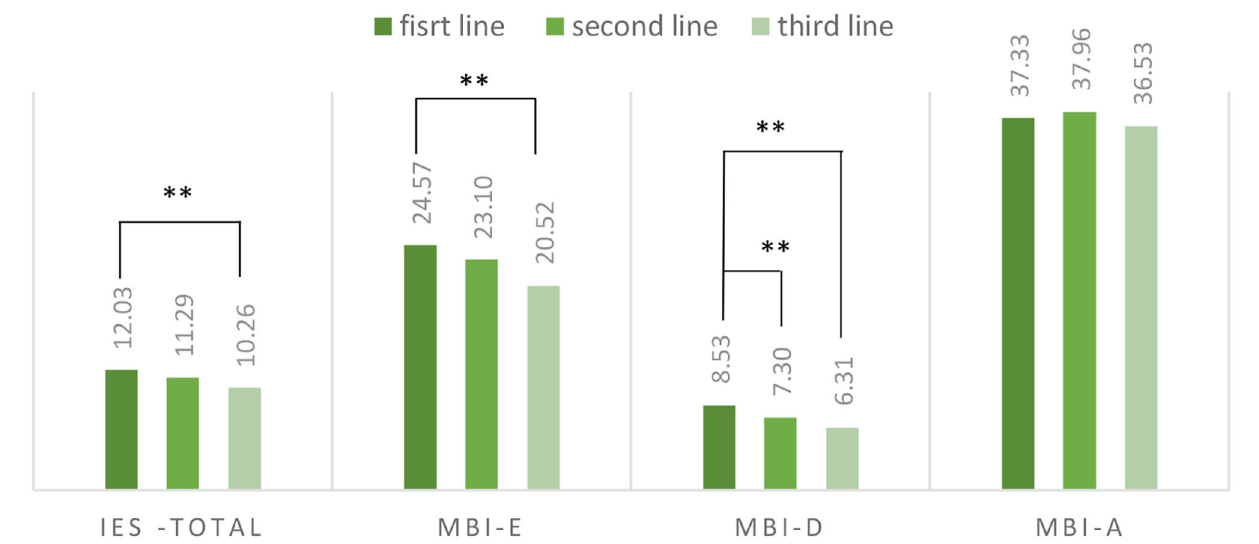
FIGURE 1 | Emotional difficulties depending on the level of exposure. MBI-E, Maslach Burnout Inventory-Exhaustion; MBI-D, Maslach Burnout Inventory-Depersonalization; MBI-A, Maslach Burnout Inventory-Accomplishment. **Significant difference.